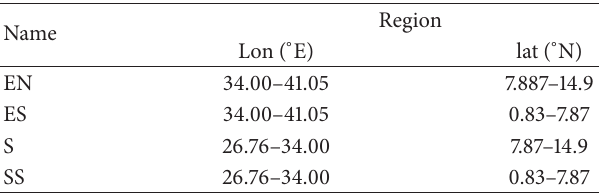
Table 1: Geographical coordinates of the selected regions (cf. Figure